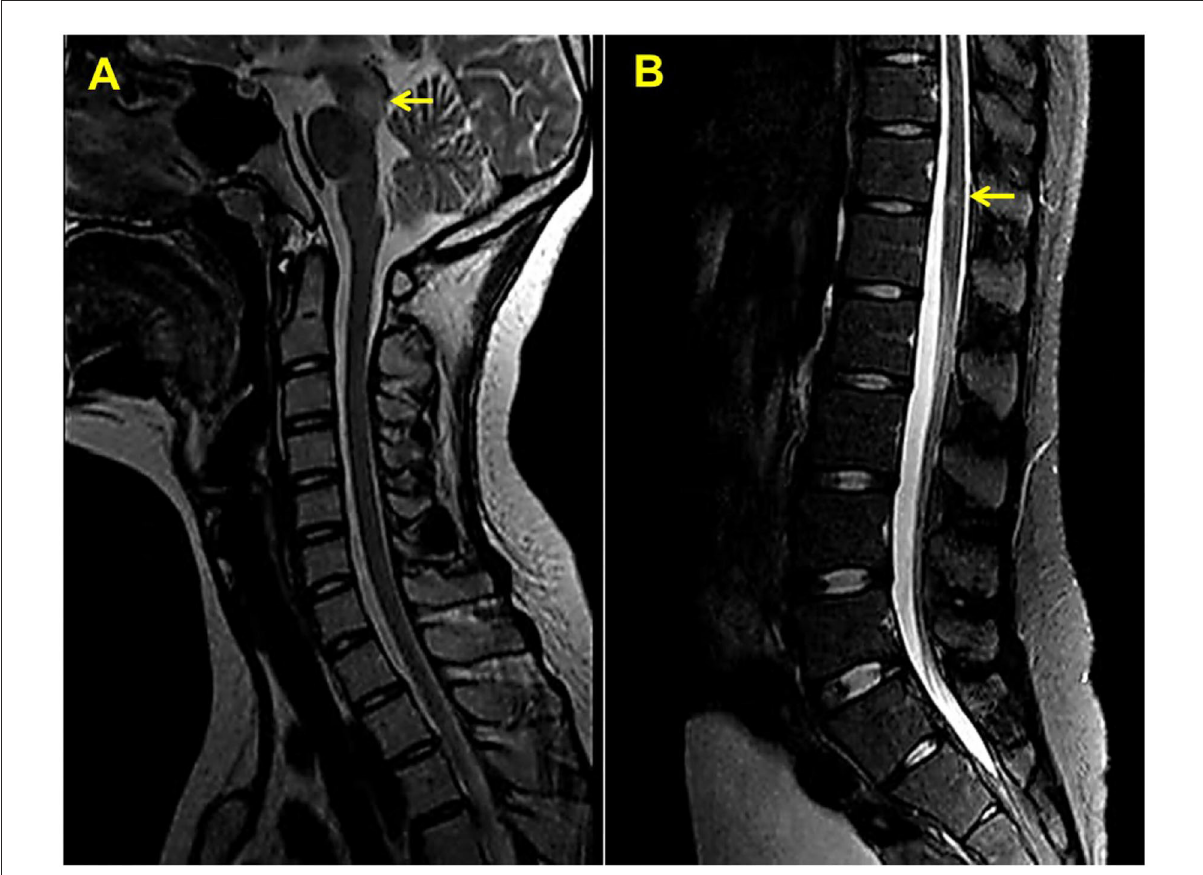
FIGURE2 Sagittal T2-weighted magnetic resonance imaging of the upper (A) and lower (B) spinal cord. Yellow arrows indicate white matter lesions.